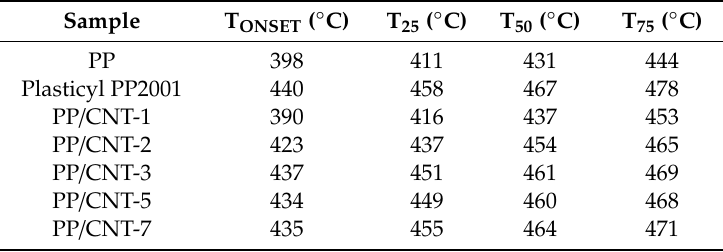
Figure 5. (a) Elastic modulus and (b) strain at failure as a function of CNTs wt% content Figure 6. (a) PP/CNT ‐ 3, (b) PP/CNT ‐ 5 and (c) PP/CNT ‐ 7